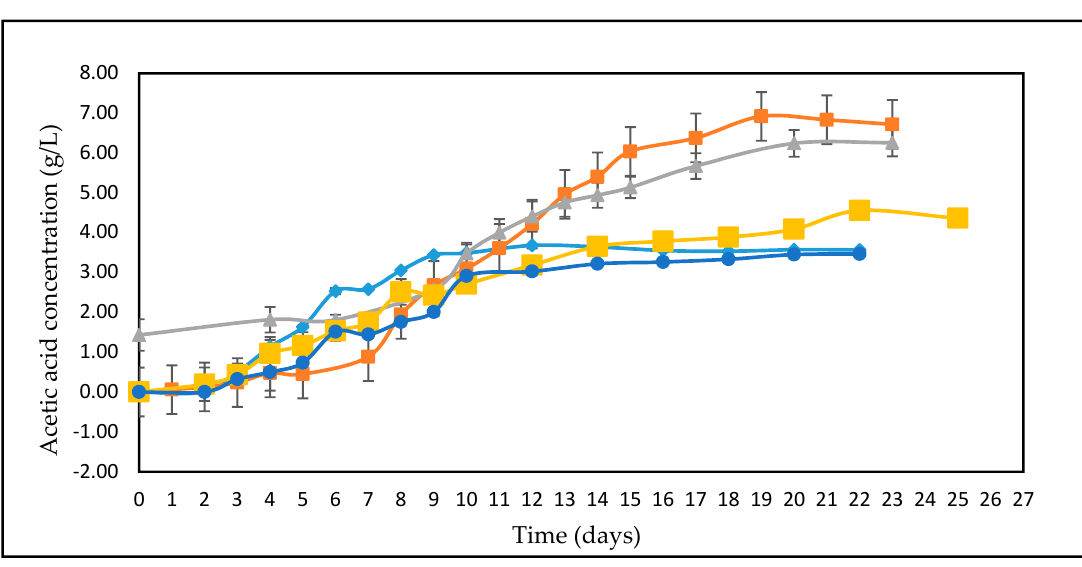
Figure 2. Effect of different concentrations of glucose on the growth of A. woodii over time measured in mg/L microbial biomass for: 5 g/L glucose ( (cid:117) ), 10 g/L glucose ( (cid:4) ), 20 g/L glucose ( (cid:78) ), 30 g/L glucose ( (cid:110) ), 40 g/L glucose ( (cid:108) ). (all the standard deviations were less than 5% and cannot be seen in the graph).